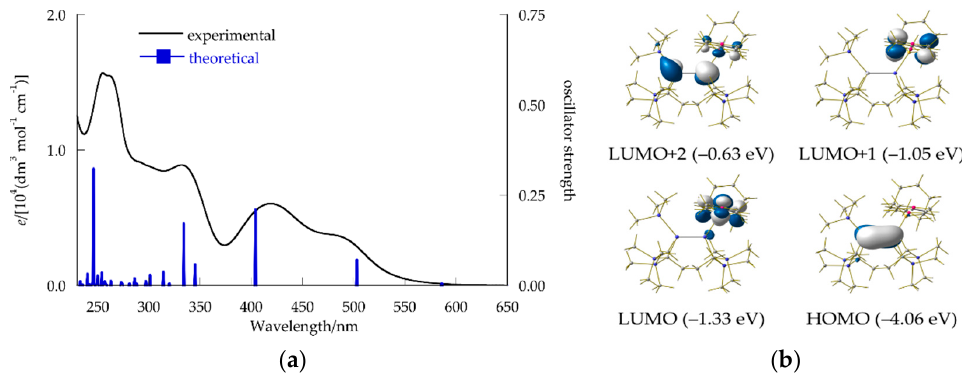
Figure 7. ( a ) UV-vis absorption spectrum of 5 in hexane at room temperature and theoretical band positions and oscillator strengths (vertical bars) calculated at the B3LYP-D3/B1(hexane)//B3PW91- D3/6-31G(d) level of theory (B1: 6-311G(2df) [Si], 6-311G(d) [N, C, B, H]). ( b ) Selected frontier Kohn–Sham orbitals calculated at the same level.